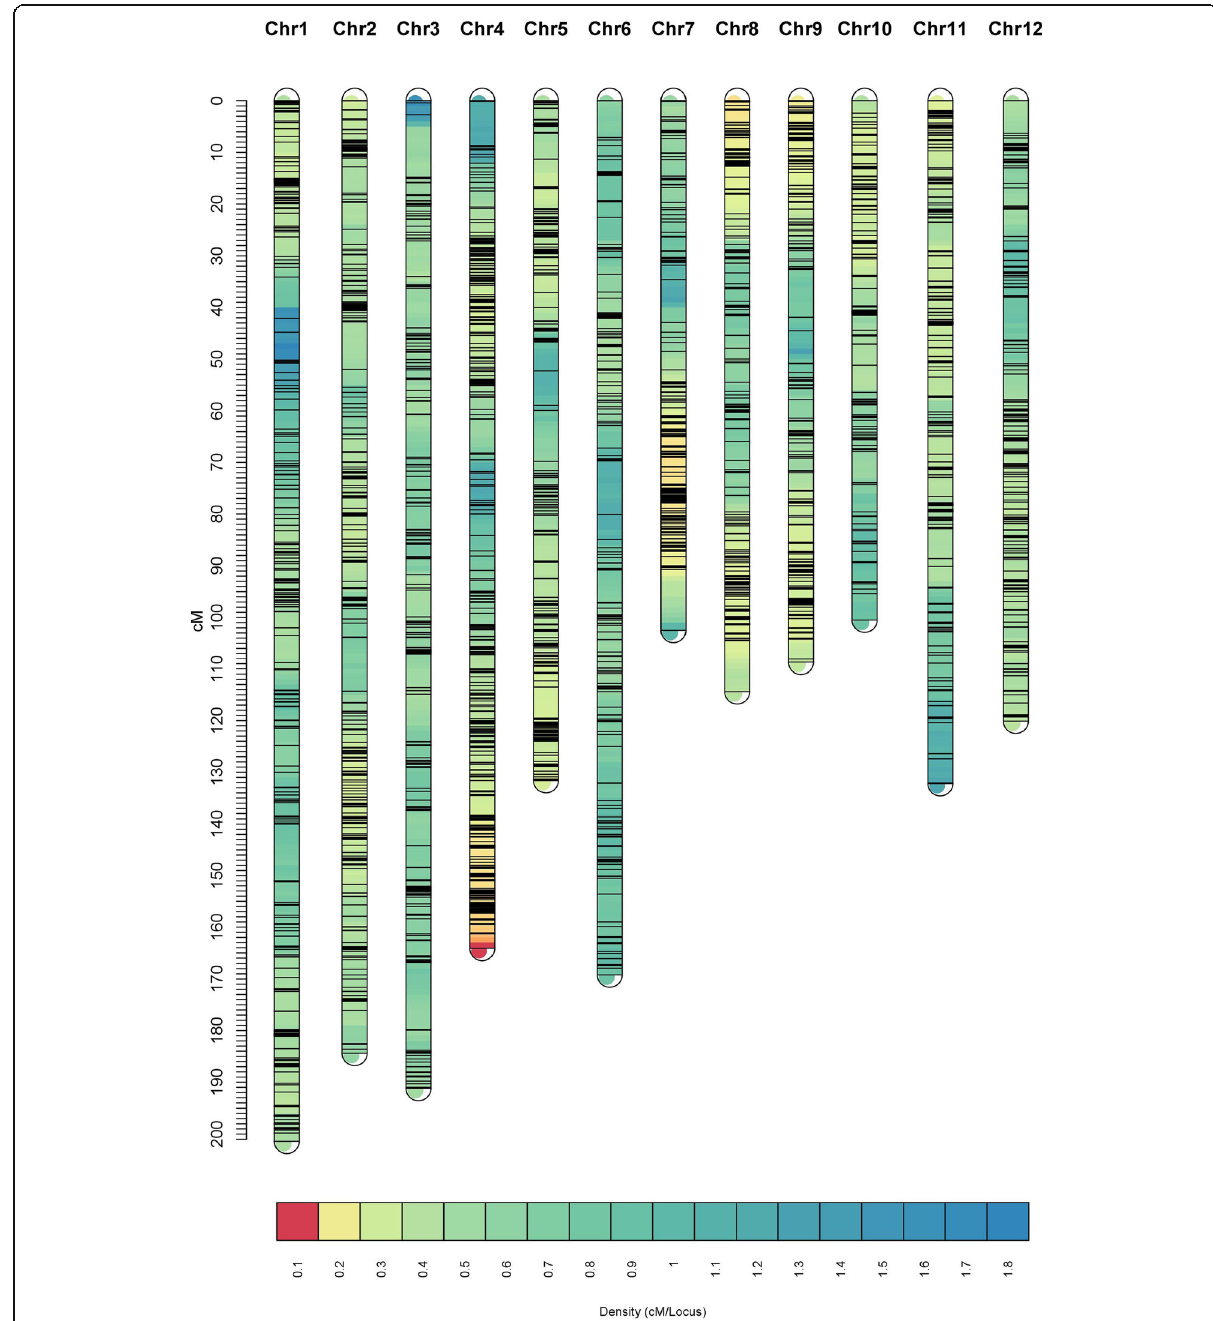
Fig. 3 Linkage map constructed by GAPL from